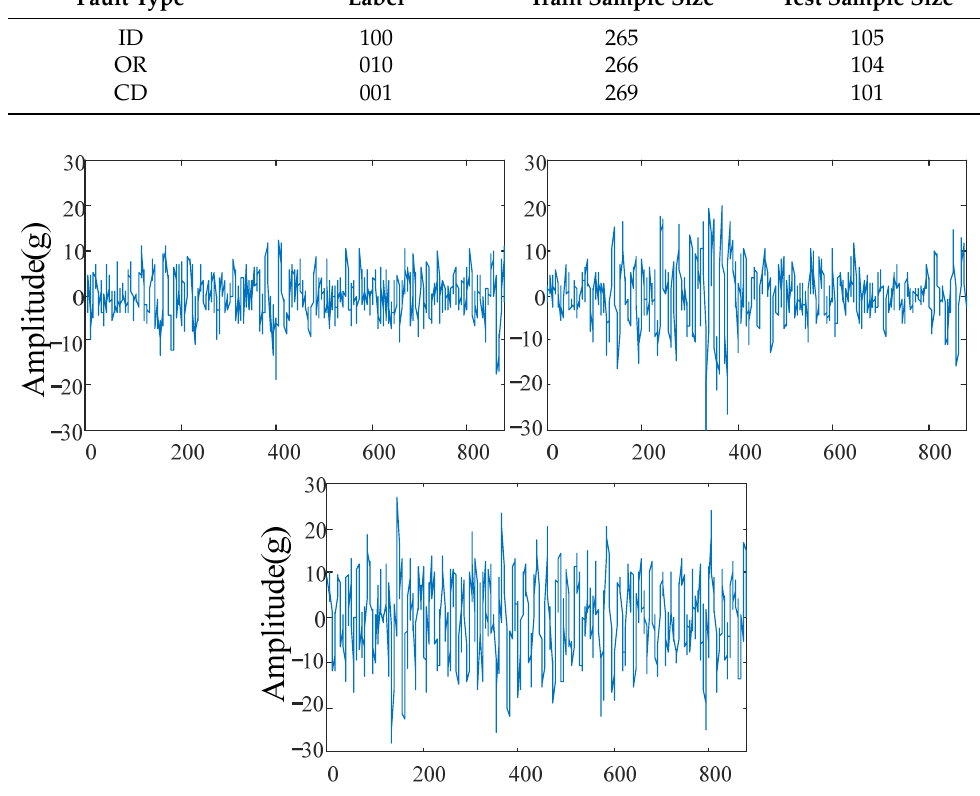
Figure 12. Acceleration signals for the three types of faults.